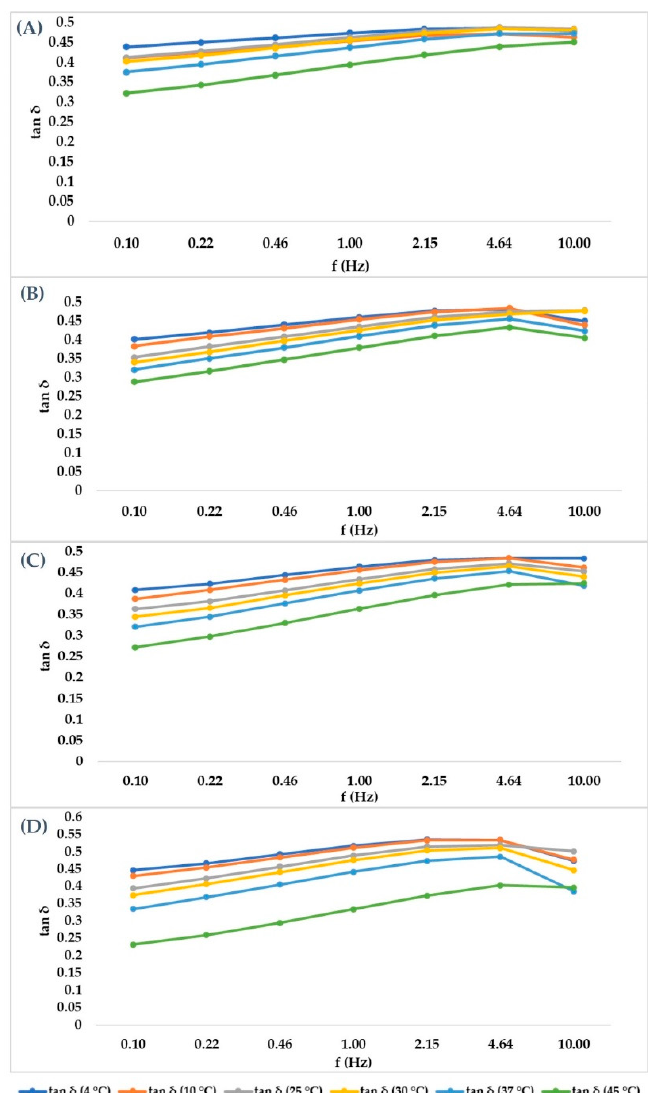
Figure 5. Cross-linked HA hydrogels graphical representation of the tangent of phase angle in order to summarize the trend of G’ and G’’, with tan δ given by the ratio of G’’/G’. ( A – D ) are graphical representations of the cross-linked HA 28, 26, 24 and 22 mg/mL trends, increasing frequency.